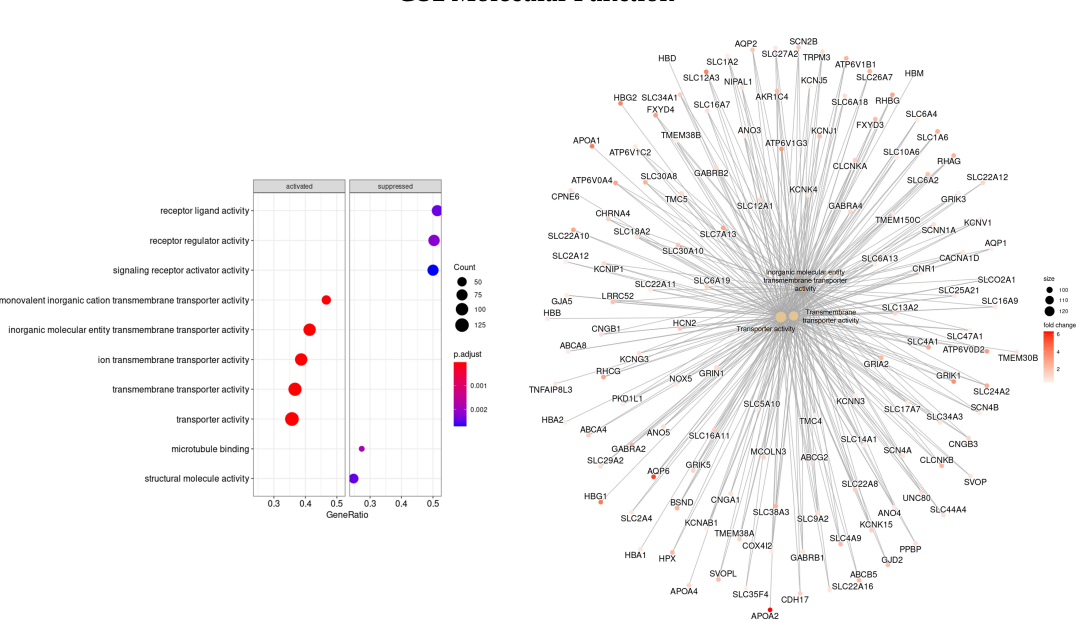
Figure 5. Gene ontology enrichment analysis regarding molecular functions terms for a list of DEGs ranked by the log fold change between early and advanced stages of the disease. The left panel shows a dot chart with the most significant MF terms. The right panel shows a gene-concept network plot of the three most enriched terms that depicts the linkages of genes and biological concepts as a